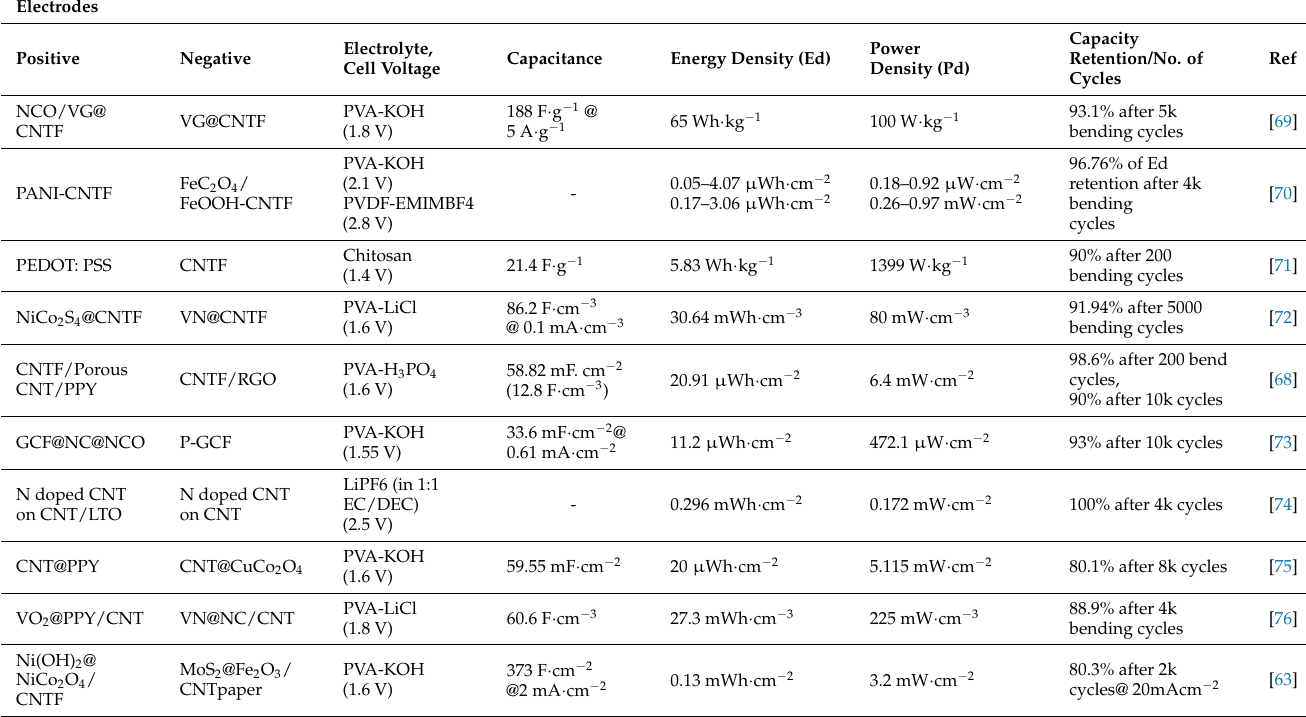
Table 4. Summary of the asymmetric supercapacitors and their characteristics recently reported in the